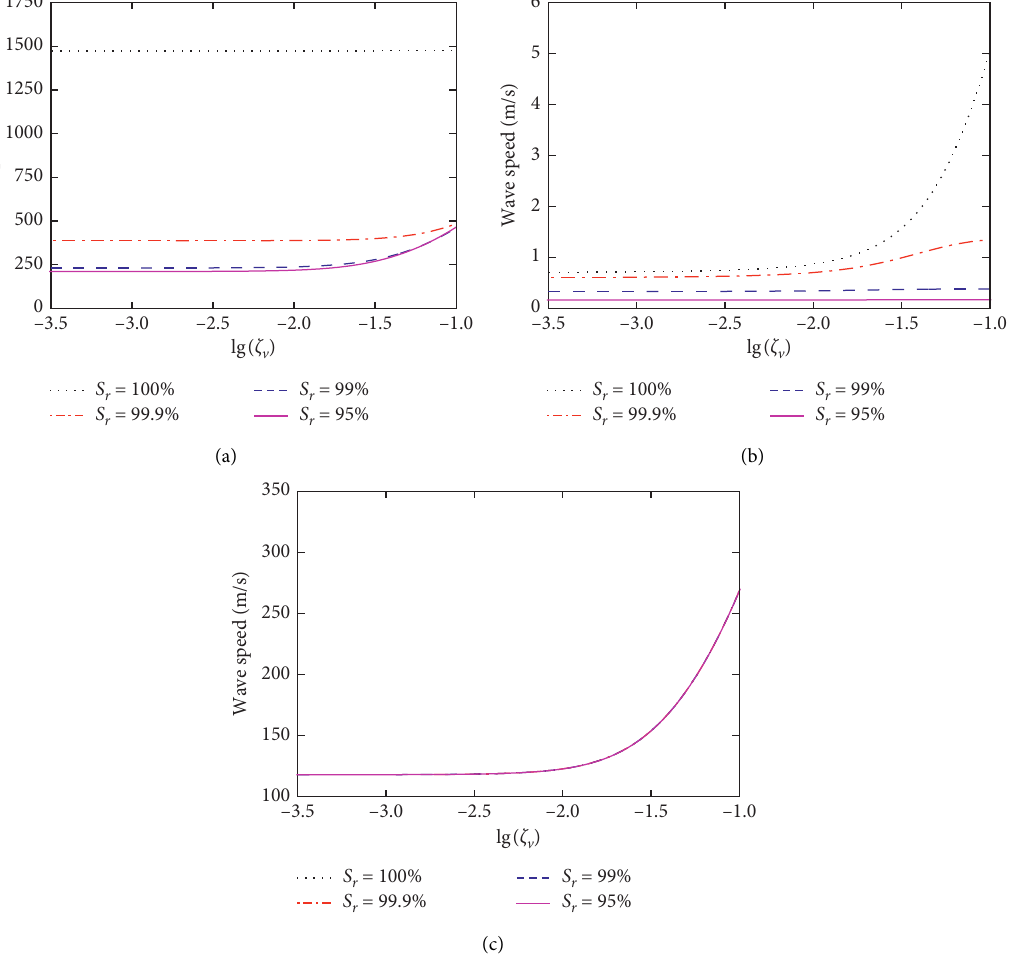
v . (a) P1 wave. (b) P2 wave. (c) S